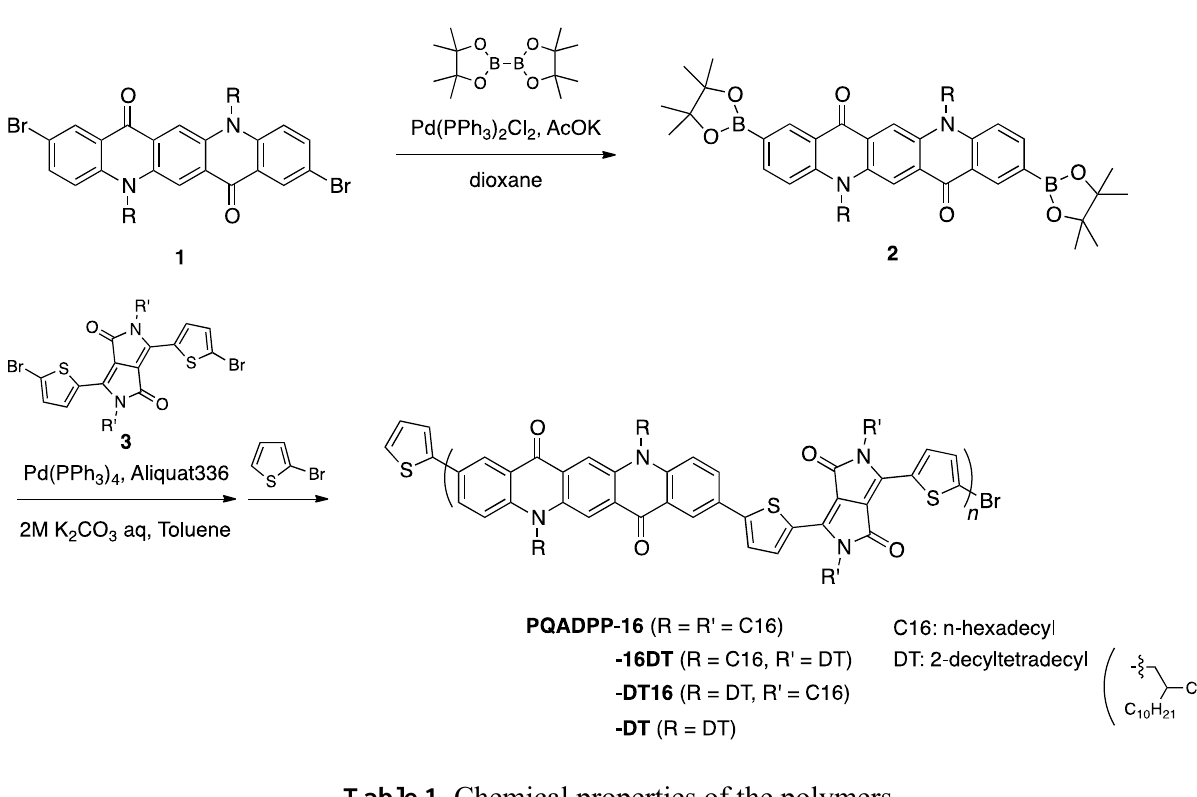
Table 1. Chemical properties of the